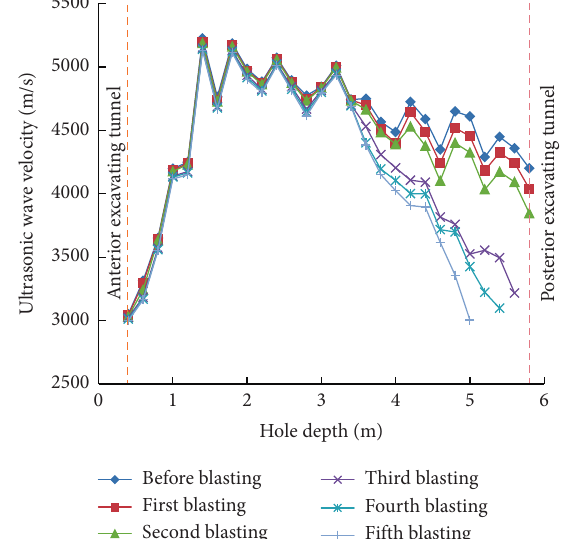
Figure 9: Relation curves between ultrasonic wave velocity and hole depth ( L